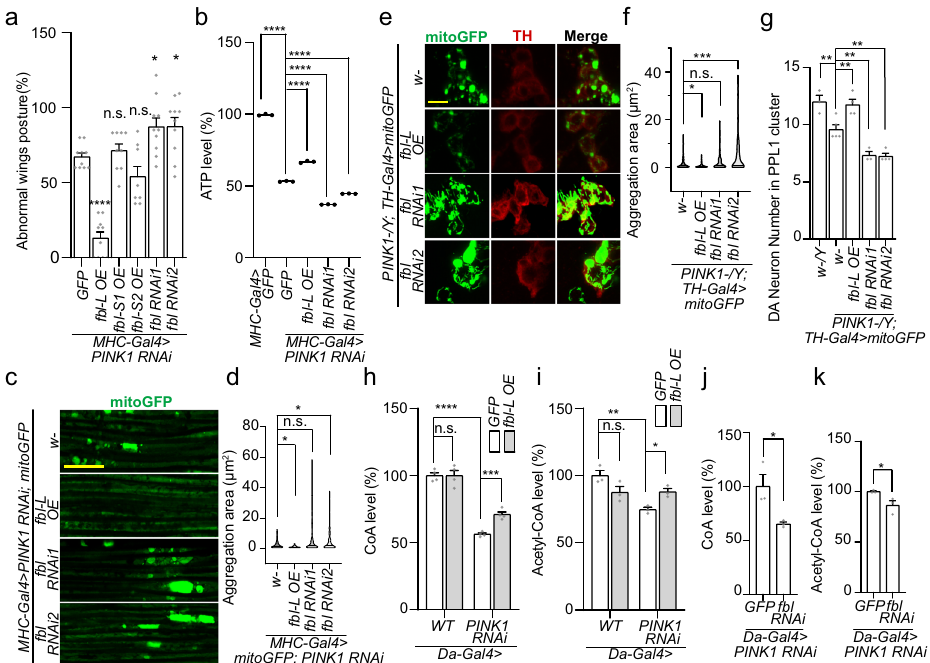
Fig. 2 Genetic Interaction Between fbl and PINK1 . a Effects of Fbl variants on wing posture defect caused by PINK1 RNAi in the indirect fl ight muscles. 25 fl ies per genotype per group were tested; n = 8 ( fbl-S2 OE), n = 9 ( fbl-S1 OE) and n = 10 (other genotypes) biologically independent groups. b Effects of Fbl on ATP level reduction caused by PINK1 RNAi. In this and all subsequent ATP measurement fi gures, n = 3 biologically independent samples. For assays in ( a , b ) UAS-GFP serves as control, and the signi fi cance was calculated by using one way ANOVA followed by post hoc Dunnett ’ s multiple comparation test. c , e Immunostainings showing effects of Fbl on mitochondrial aggregations in fl ight muscles ( c ) and DA neurons ( e ) caused by PINK1 LOF. Scale bars: ( c ) 25 µ m; ( e ) 10 µ m. In this and all subsequent immunostaining fi gures of fl y muscle and DA neurons, mitochondrial morphology is monitored with a mitoGFP reporter. d , f Violin plots showing the quanti fi cations corresponding to ( c ) and ( e ). In mitochondrial quanti fi cations in muscle and neurons, the signi fi cance was calculated by using two-proportion Z test, the threshold was set at 3 µ m 2 , and n = 3 biologically independent samples. g Effects of Fbl on DA neurons ’ loss in PPL 1 cluster of PINK1 mutant. n = 3 ( w, PINK1/fbl RNAi1 ), n = 4 ( PINK1/ fbl OE and PINK1 /fbl RNAi2 ), and n = 5 ( PINK1 ) biologically independent animals. h , i Effects of Fbl ectopic expression on CoA and acetyl-CoA levels in WT and PINK1 RNAi fl ies. j , k Effects of fbl RNAi on CoA and acetyl-CoA levels in PINK1 RNAi fl ies. n = 4 biologically independent samples in assays ( h ) n = 3 biologically independent samples in assays ( j – k ). For assays in ( g ),